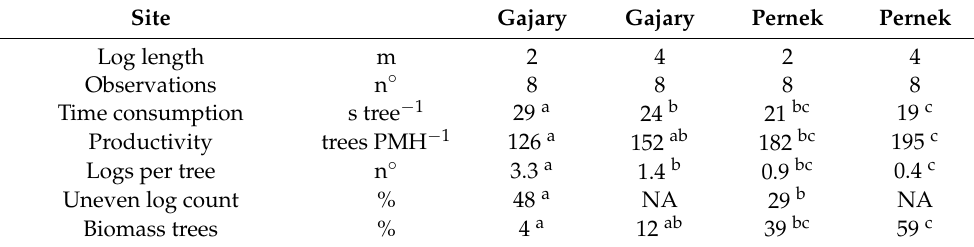
Table 5. Results from the cycle-level study conducted on the harvester.